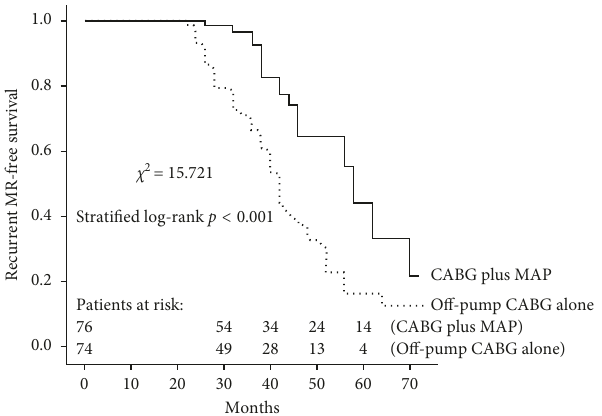
Figure 5: Kaplan–Meier analysis for recurrent IMR-free survival in the matched